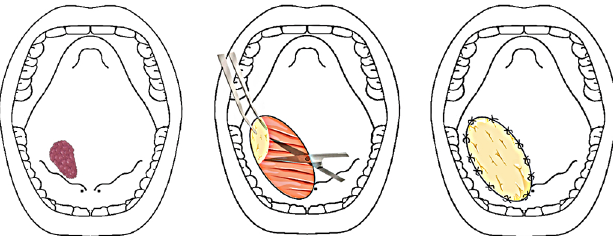
Fig. 1. Schematic representation of the surgical technique for sublingual gland fl ap harvesting and reconstruction of an oral fl oor defect. Lesion of the right fl oor of the mouth (a), harvesting of the sublingual gland after removal of the lesion (b), outcome of the sublingual fl ap (c).